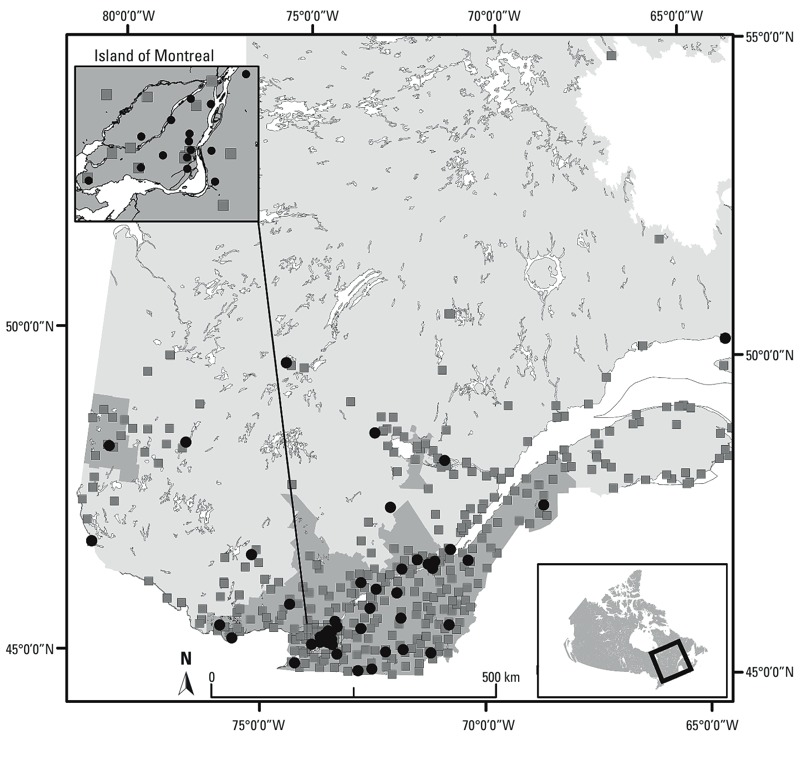
Geographical location of O3 monitoring (black circles) and meteorological stations (gray squares) in the study region (dark gray). Locations are for monitors used at any time during the study period.